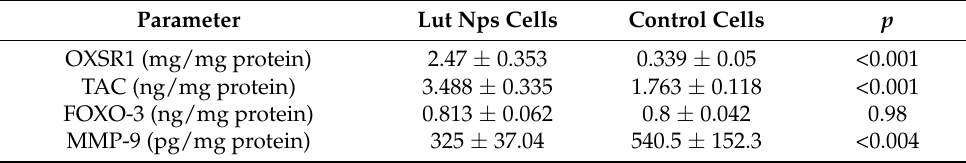
Figure 2. ( a ) Mean values of OXSR1 (mg/mg protein), TAC (ng/mg protein), FOXO-3 (ng/mg protein) in lutein (100 mg) treated oral cancer cells, and control cells (Lut 100—oral cancer squamous cells incubated with lutein (100 mg); CR—control oral cancer squamous cells): 1-OXSR-1, 2-TAC, 3-FOXO-3. * indicates a statistically significant difference. ( b ) Mean values of MMP-9 (pg/ mg protein) in lutein (100 mg) treated oral cancer cells, and control cells (Lut 100—oral cancer squamous cells incubated with lutein, 100 mg; CR—control oral cancer squamous cells). Table 2. Mean values of OXSR1, TAC, FOXO-3 and MMP-9 in lutein Nps—Lut Nps-treated oral cancer cells and control cells (Lut Nps—oral cancer squamous cells incubated with lutein nanoparticles; CR—control oral cancer squamous